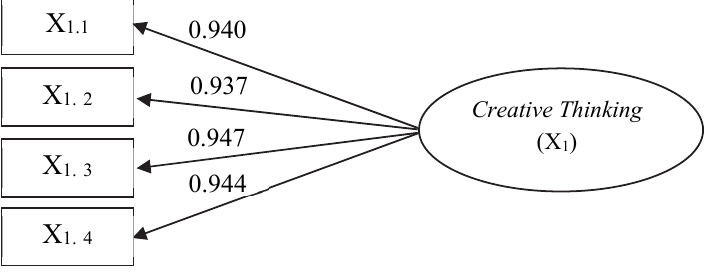
Fig. 2. Analysis of Creative Thinking Confirmatory Factors